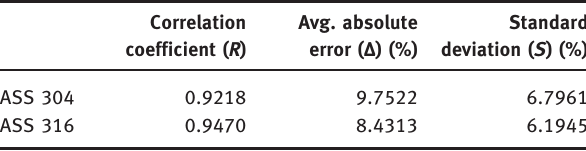
Table 6: Statistical parameters for m-FB model.